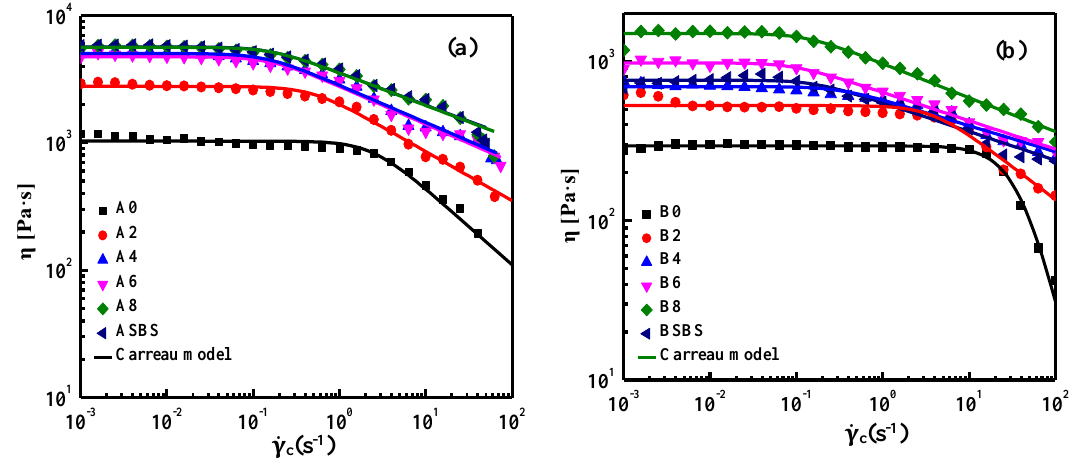
Figure 6. Flow curves of the base and SBS-latex-modified asphalts.